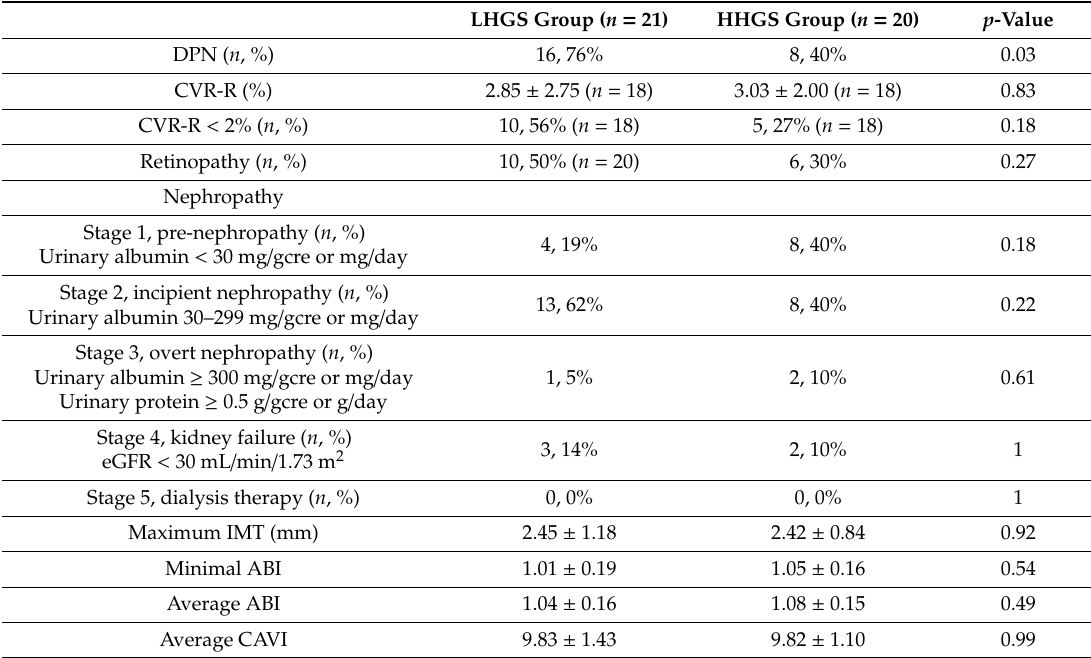
Table 3. Laboratory parameters. (Table 4). Hence, patients with LHGS showed higher serum phosphorous concentrations than those in the HHGS group. Table 2. Diabetic microangiopathy and surrogate markers of atherosclerosis.